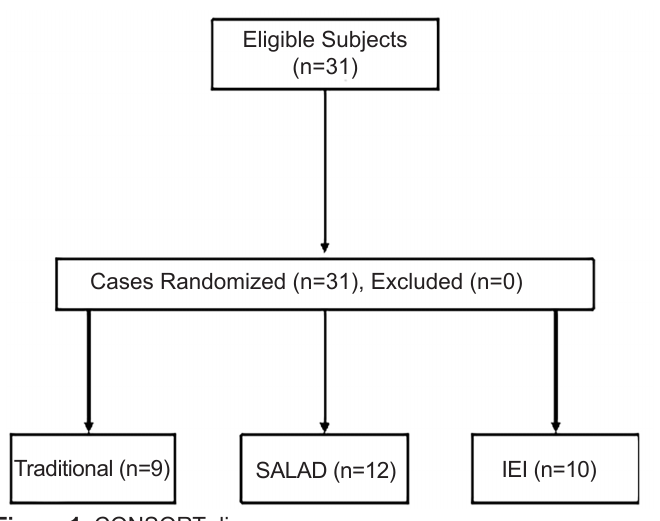
Figure 1. CONSORT diagram.